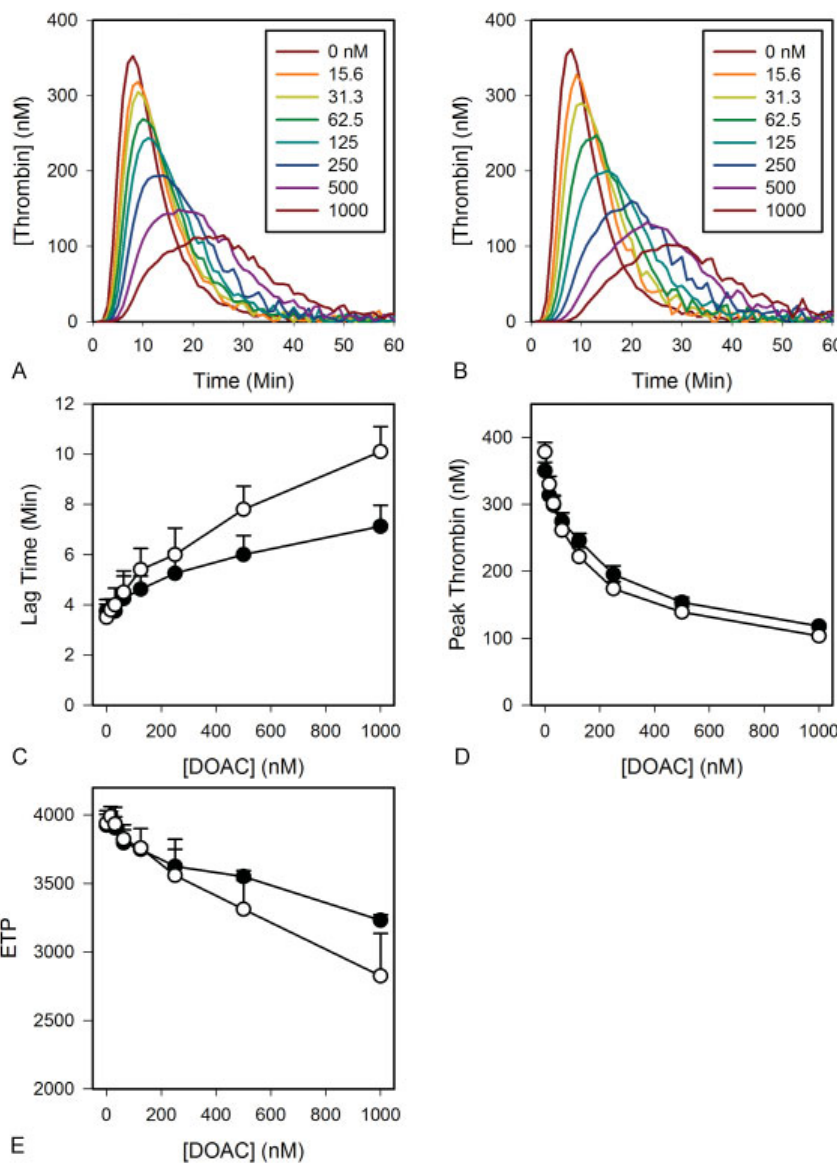
Fig. 2 Comparison of the effects of apixaban and rivaroxaban on thrombin generation in plasma. Thrombin generation in plasma containing 4 µM PCPS was triggered by addition of 3 pM tissue factor and 7.5 mM CaCl 2 and quanti fi ed by monitoring the hydrolysis of 0.5 mM Z-Gly-Gly- Arg-AMC in the absence or presence of ( A ) apixaban, or ( B ) rivaroxaban, at the indicated concentrations. Using the thrombin generation pro fi les, ( C ) lag time, ( D ) peak thrombin concentration, and ( E ) ETP are measured and plotted versus the concentrations of apixaban ( closed ) or rivaroxaban ( open ). Data re fl ect the mean (cid:3) SD of three experiments. ETP, endogenous thrombin